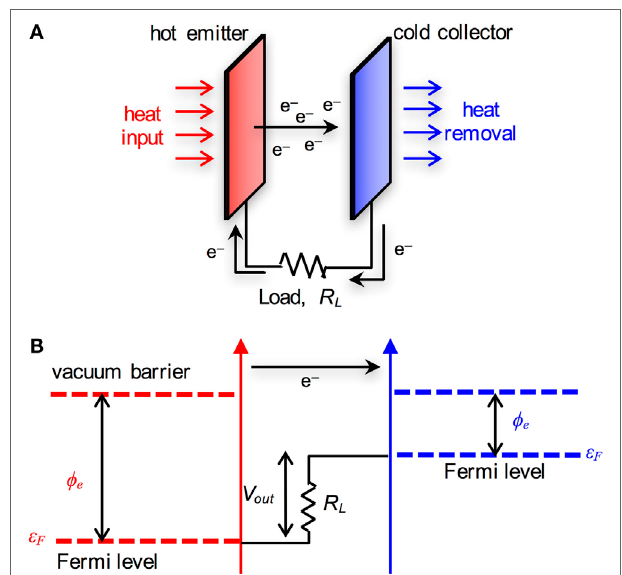
FigURe 1 | (A) Schematic of the thermionic energy conversion (TEC) process. (B) Electromotive diagram showing electron energy levels during TEC.